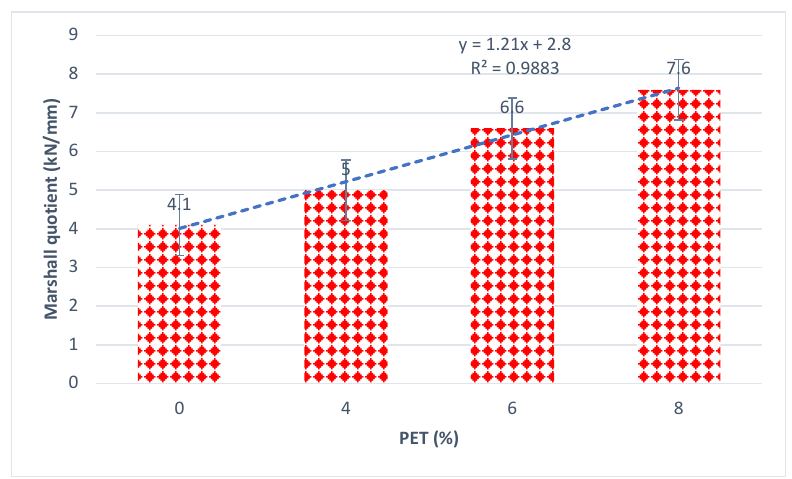
Figure 6. MQ results for the PET-modified AC asphalt mixtures. Recycling 2022 , 7 , x FOR PEER REVIEW